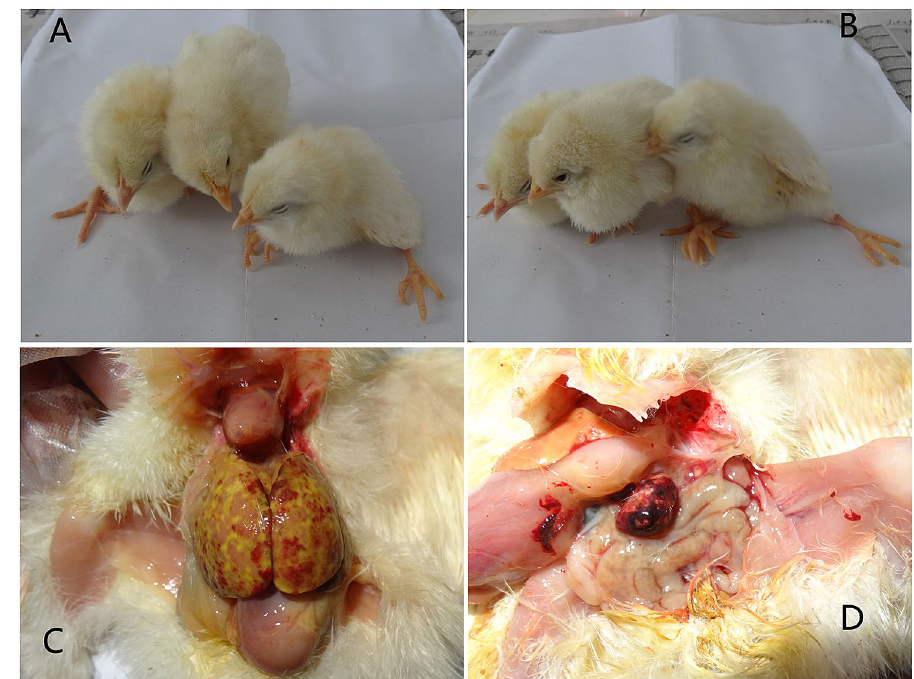
Figure 1. Clinical signs and gross lesions of chickens infected with NDRV by the s.c. route. ( A ) Chickens displayed depression, craws curling at 3 dpi. ( B ) Chickens displayed performing splits at 3 dpi. ( C ) Yellowish- white focal necrosis on the surface or in the parenchyma of liver. ( D ) Swelling, bleeding and yellowish-white focal necrosis on the surface or in the parenchyma of spleen.